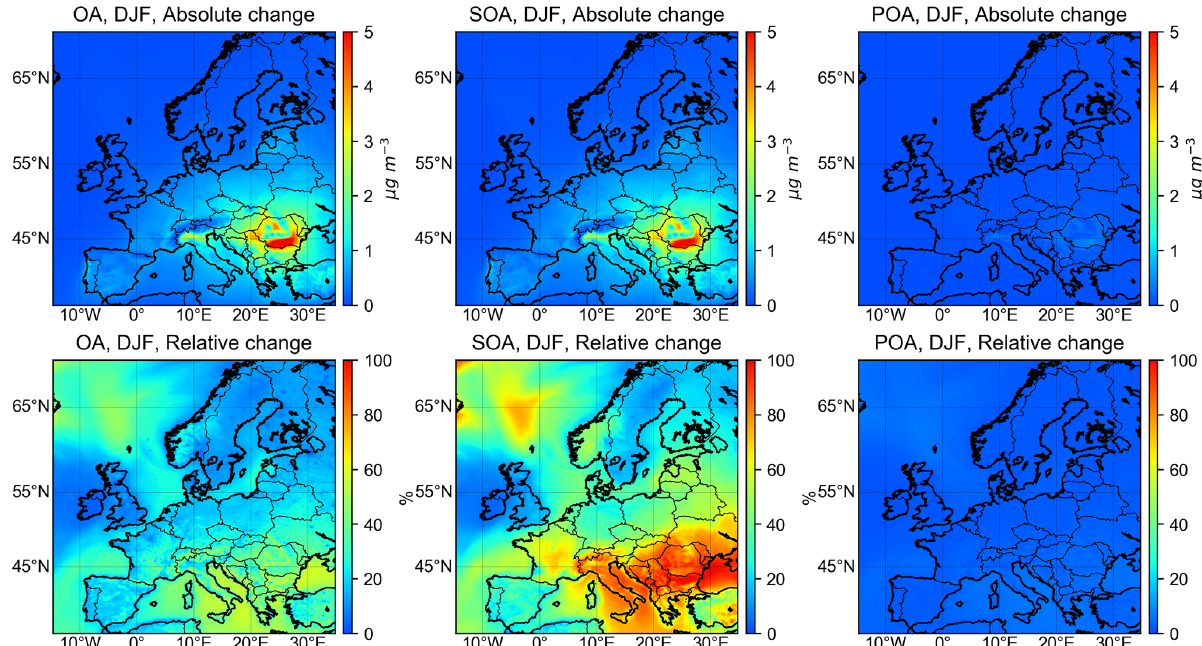
Figure 7. Differences in modeled OA, SOA, and POA in winter (DJF, December–January–February) by VBS schemes with (VBS_WLS) and without (VBS_noWLS) vapor wall corrections.